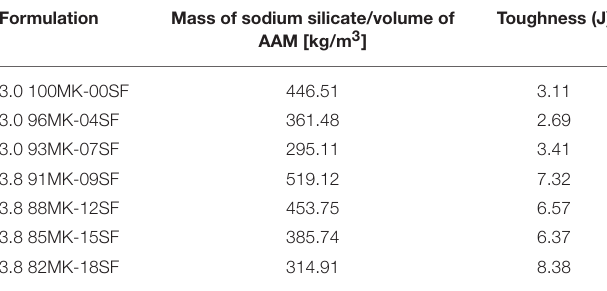
TABLE 6 | Amount of silicate used and toughness obtained in each formulation.